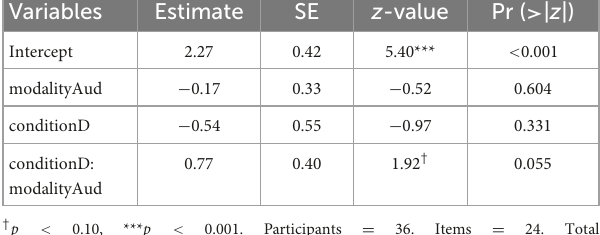
TABLE 8 Results of GLME model analysis of accuracy rates in the translational congruency